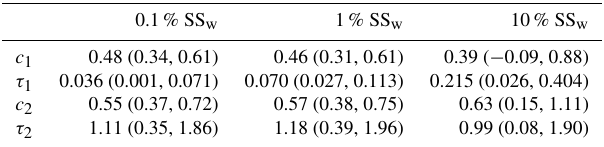
Table D1. Bi-exponential fit